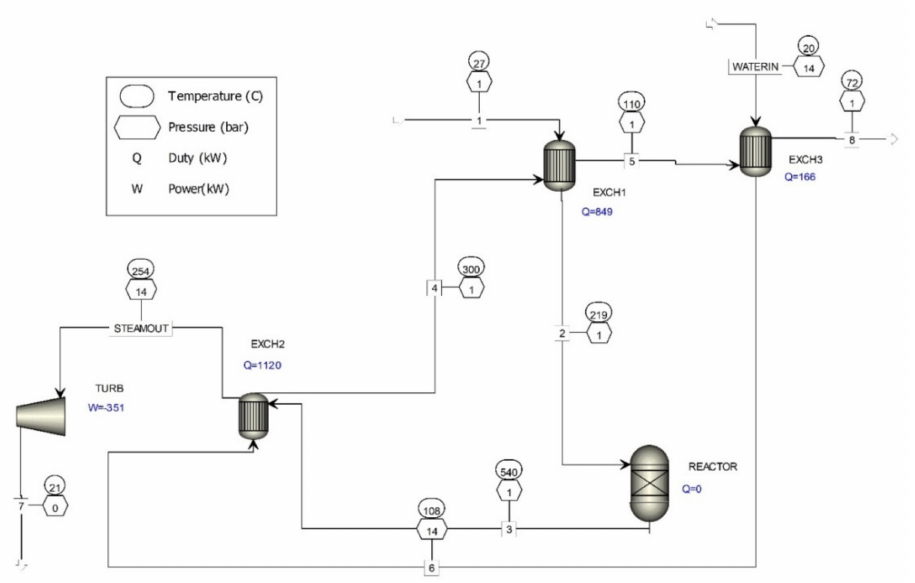
Figure 2. Computer simulation of waste gas treatment in the oxide catalyst formaldehyde production process, utilizing heat to produce